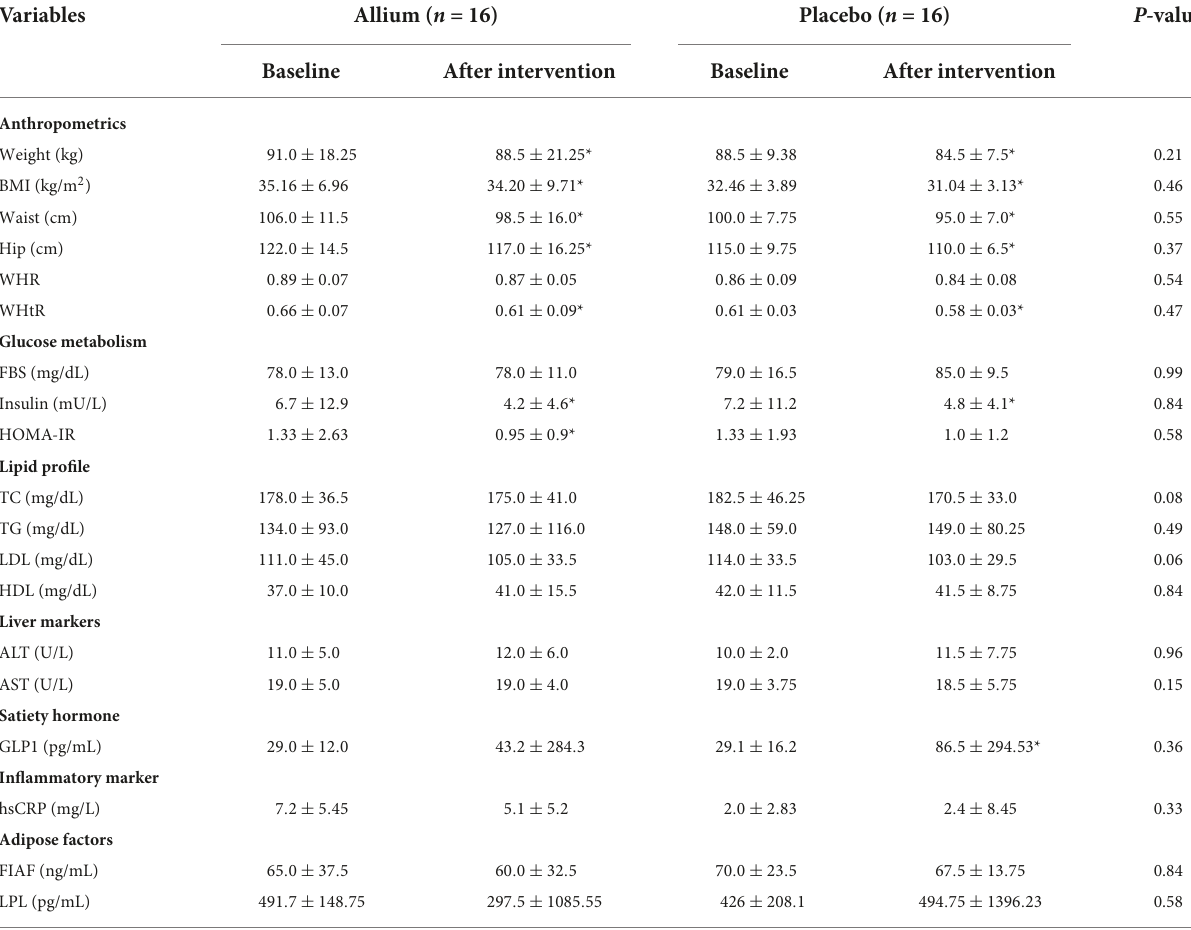
TABLE 3 Effects of 2 months consumption of Allium and placebo on anthropometric indices and biochemical variables in obese women.